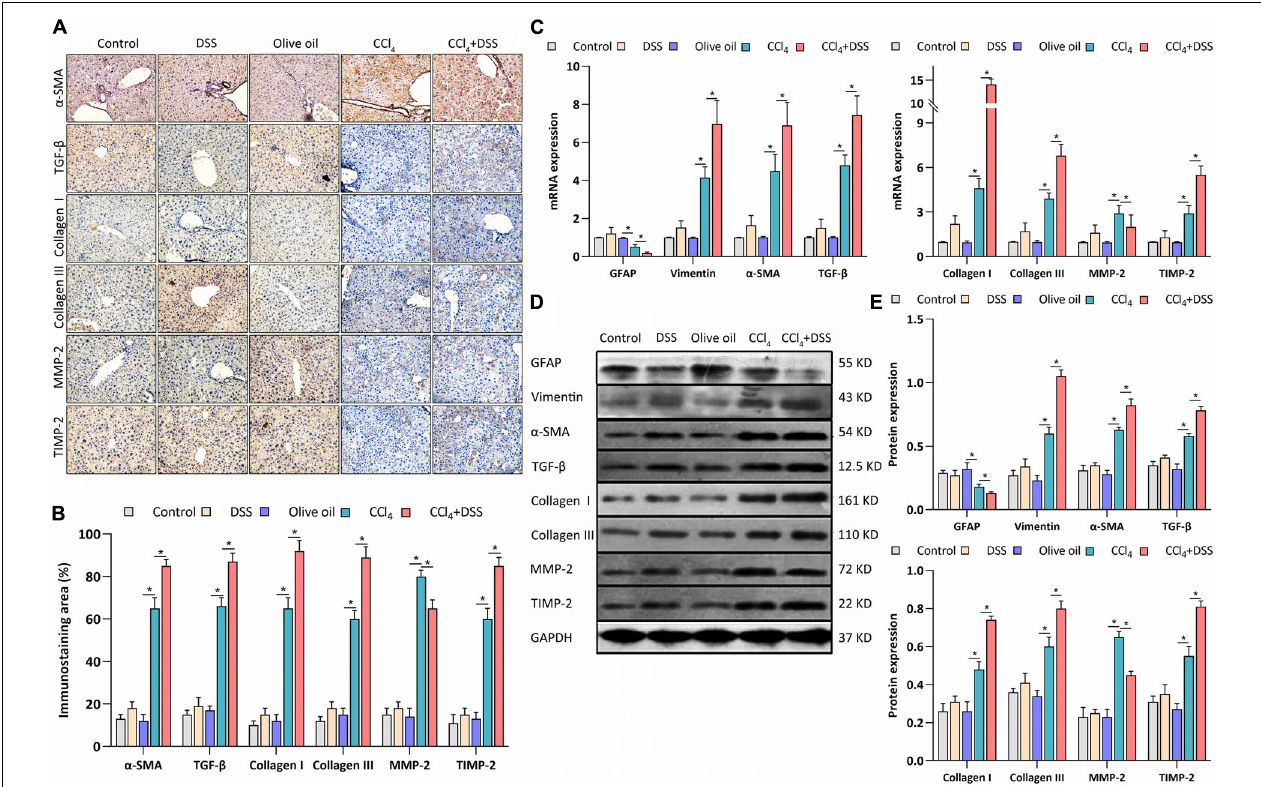
FIGURE 4 | DSS promoted the activation of HSCs in CCl 4 -induced liver fibrosis mice. (A) Representative images of IHC staining liver sections (magnifications × 400) and (B) staining intensity of proteins-related to HSCs activation were shown; (C–E) Expression levels of proteins-related to HSCs activation in liver were measured by qRT-PCR (C) and western blot (D,E) . Data were expressed as mean ± SD. *, p <